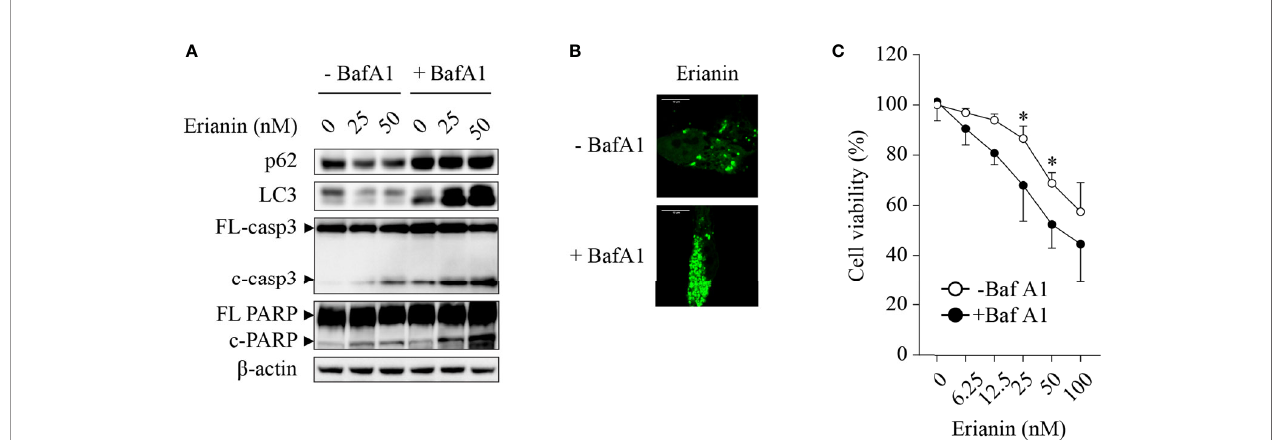
FIGURE 3 | Erianin induces pro-survival autophagy in LNCaP cells. (A) LNCaP cells were treated with erianin at indicated concentrations for 24 h in the presence or absence of 100 nM ba fi lomycin A1 (BafA1, an autophagy inhibitor). Levels of p62, LC3, cleaved caspase-3 and cleaved PARP were examined by Western blotting. FL-, full length; c-, cleaved; casp3, caspase 3. (B) LNCaP cells were transfected with GFP-tagged LC3 for 48 h. Then cells were co-treated with 100 nM BafA1 and 50 nM erianin for 24 h. Confocal images were captured. Bar = 10 µm. (C) Cells were treated with erianin at indicated concentrations in the presence or absence of 100 nM ba fi lomycin A1 for 24 h. Cell viability was determined by MTS colorimetric assay. Data are expressed as mean ± SD. n=4. * p < 0.05, -BafA1 versus